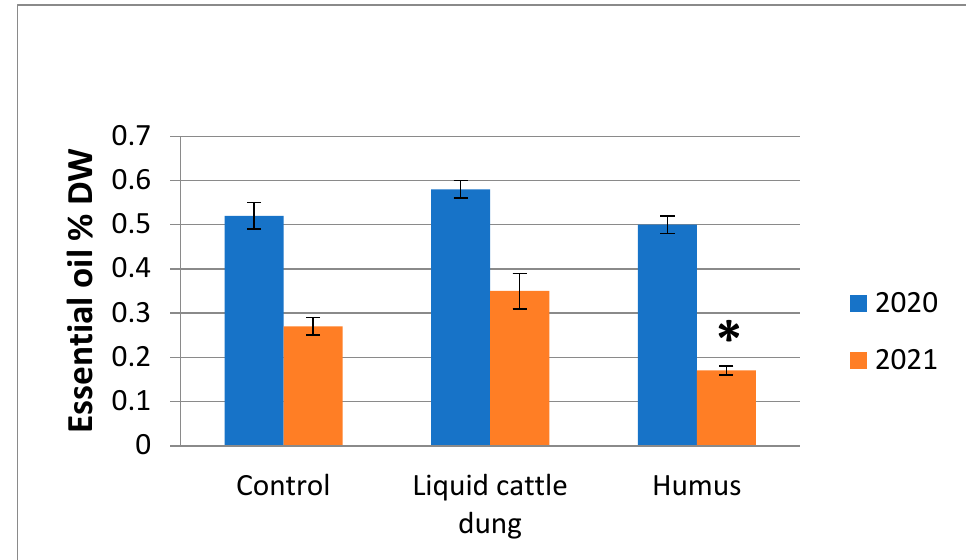
Figure 3. Variations in percentage of Thymus × citriodorus essential oil depending on the fertilization treatment in the first and second experimental years. * denotes statistically significant differences ( p < 0.05); error bars denote the standard error of mean. DW—dry weight. Geraniol was the main chemical compound of essential oils in T. × citriodorus ; it amounted to about a quarter of essential oils in both fertilization treatments and the control in the first experimental year. In the second experimental year, this chemical compound amounted to a quarter of essential oils after fertilization with liquid cattle dung and a fifth of essential oils after fertilization with humus. Fertilization with humus increased the percentage of geraniol and geranial in the first experimental year but decreased the percentage of geraniol, geranial and neral in the second experimental year. These changes in comparison with the control were not significant. The percentages of nerol and neralin essential oils were similar in all fertilization treatments in the first experimental year: nerol amounted about 14% and neral amounted to about 11% of essential oil (Figure 4, Table A1). In the second experimental year, the percentages of nerol and neral varied from the lowest to highest values (Table A1). Fertilization with liquid cattle dung decreased the percentage of germacrene D-4-ol in the first experimental year, but this result did not differ significantly from the control. In the second experimental year, both fertilization treatments increased the percentage of germacrene D-4-ol, but this increase also did not differ significantly from the control. Variations in the percentage of germacrene D-4-ol were the highest in comparison with the other four investigated chemical compounds in both experimental years (Figure 4, Table